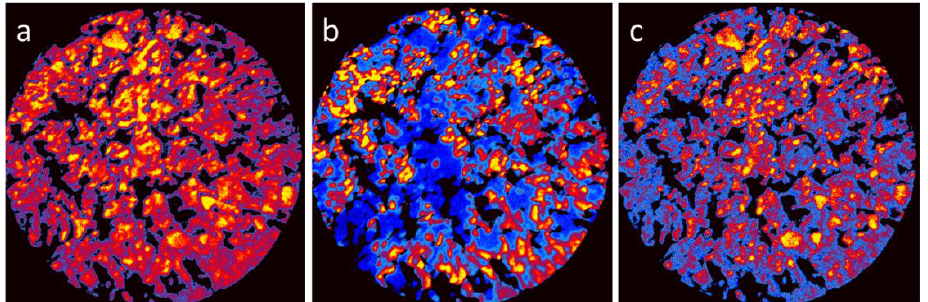
Figure 2. X-PEEM elemental maps of Co ( a ), La ( b ), and Ca ( c ) for the LCO20Ca80 composite, presented in the thermal palette. The black areas indicated the presence of voids, where the intensity was arbitrary set to zero. The field of view is 75 µ